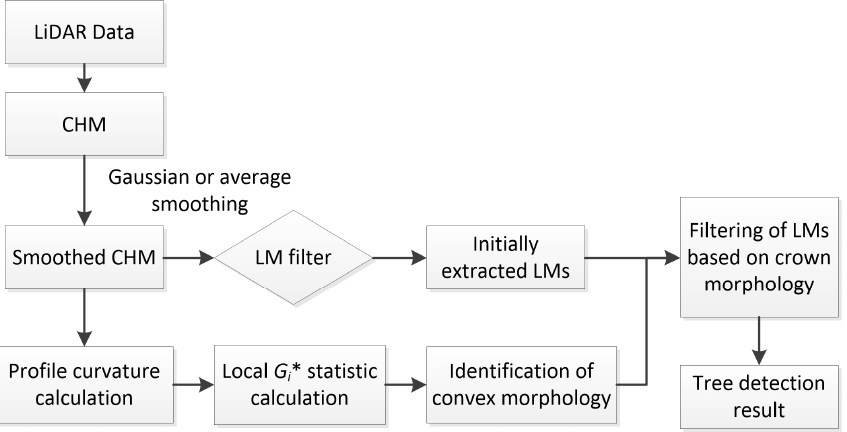
Figure 2. Workflow of the proposed tree detection approach.